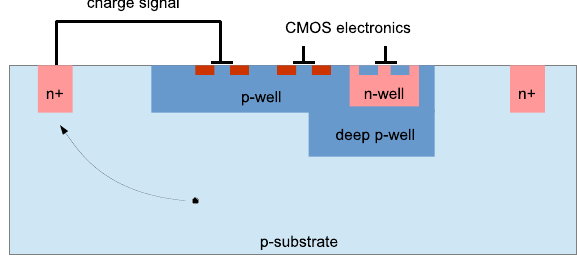
Figure 4. Diagram of a depleted CMOS DMAPS sensor with small fill-factor